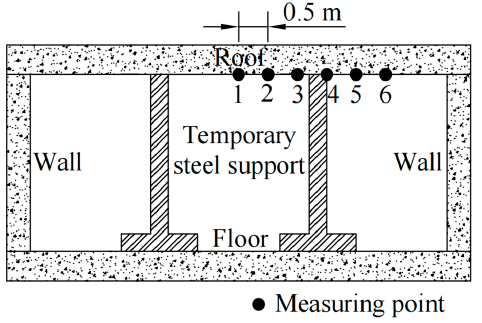
Figure 5. Schematic diagram of test point distribution [34].